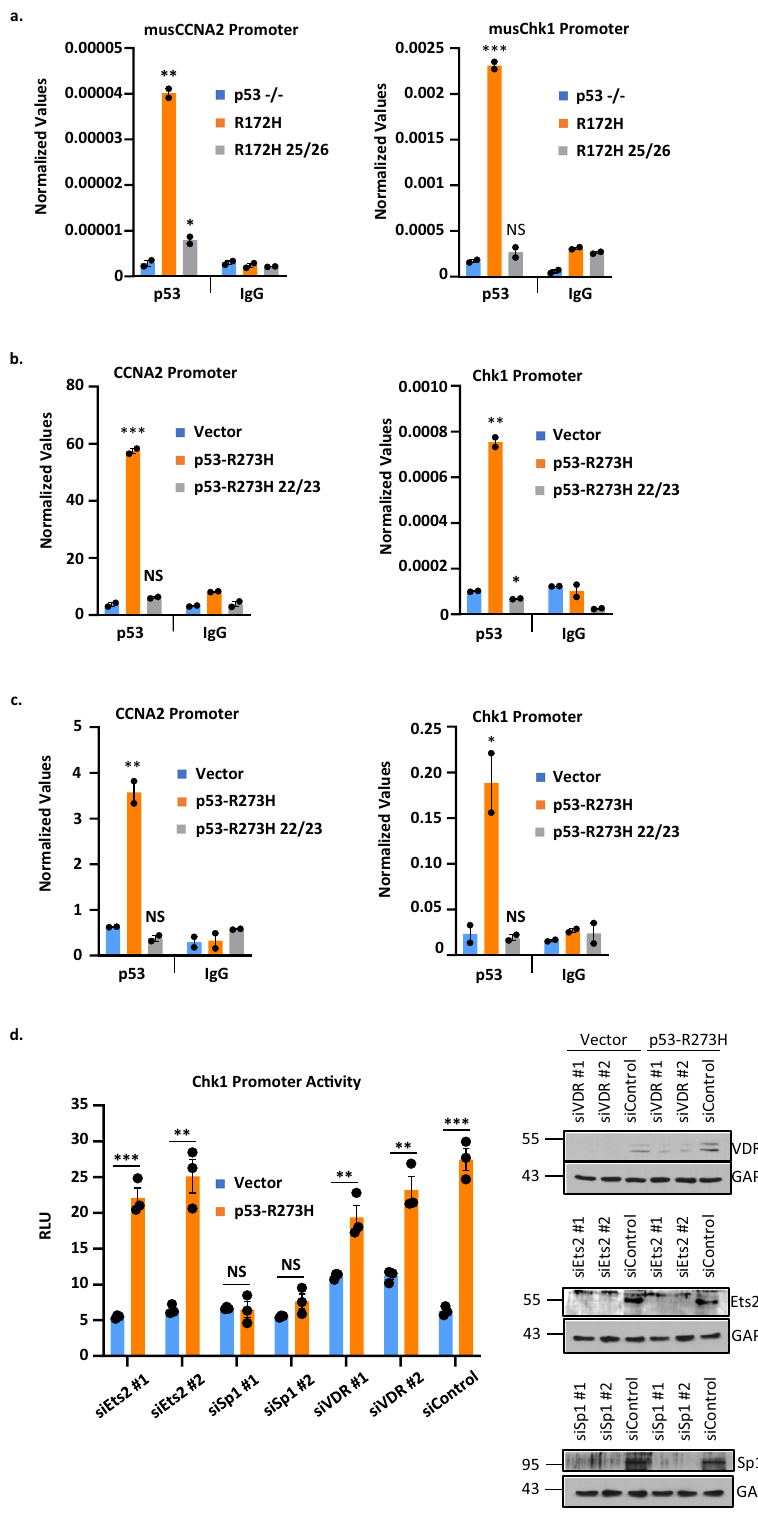
R273H and assayed promoter activity by luciferase assays. The data presented in Fig. 3d show that Chk1 promoter induction by p53-R273H is affected by Sp1 but not by VDR1 or Ets2 siRNAs, suggesting speci fi city attained by TF Sp1. These observations indicate an important role for TAD in the interaction of GOF p53 and its inducible promoter/enhancers. tion by GOF p53. Since GOF p53 seems to interact with DNA